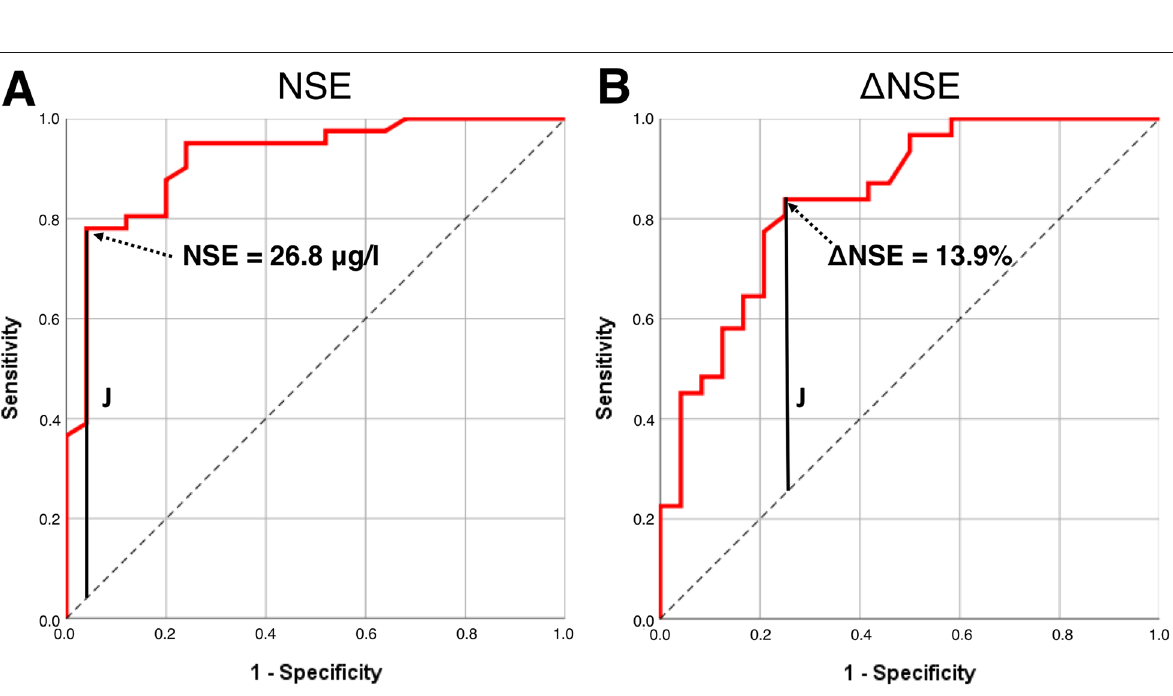
Fig. 5 ROC curves for mismatch prediction by serum NSE ( a ) and Δ NSE ( b ) with maximum value of the Youden Index ( J